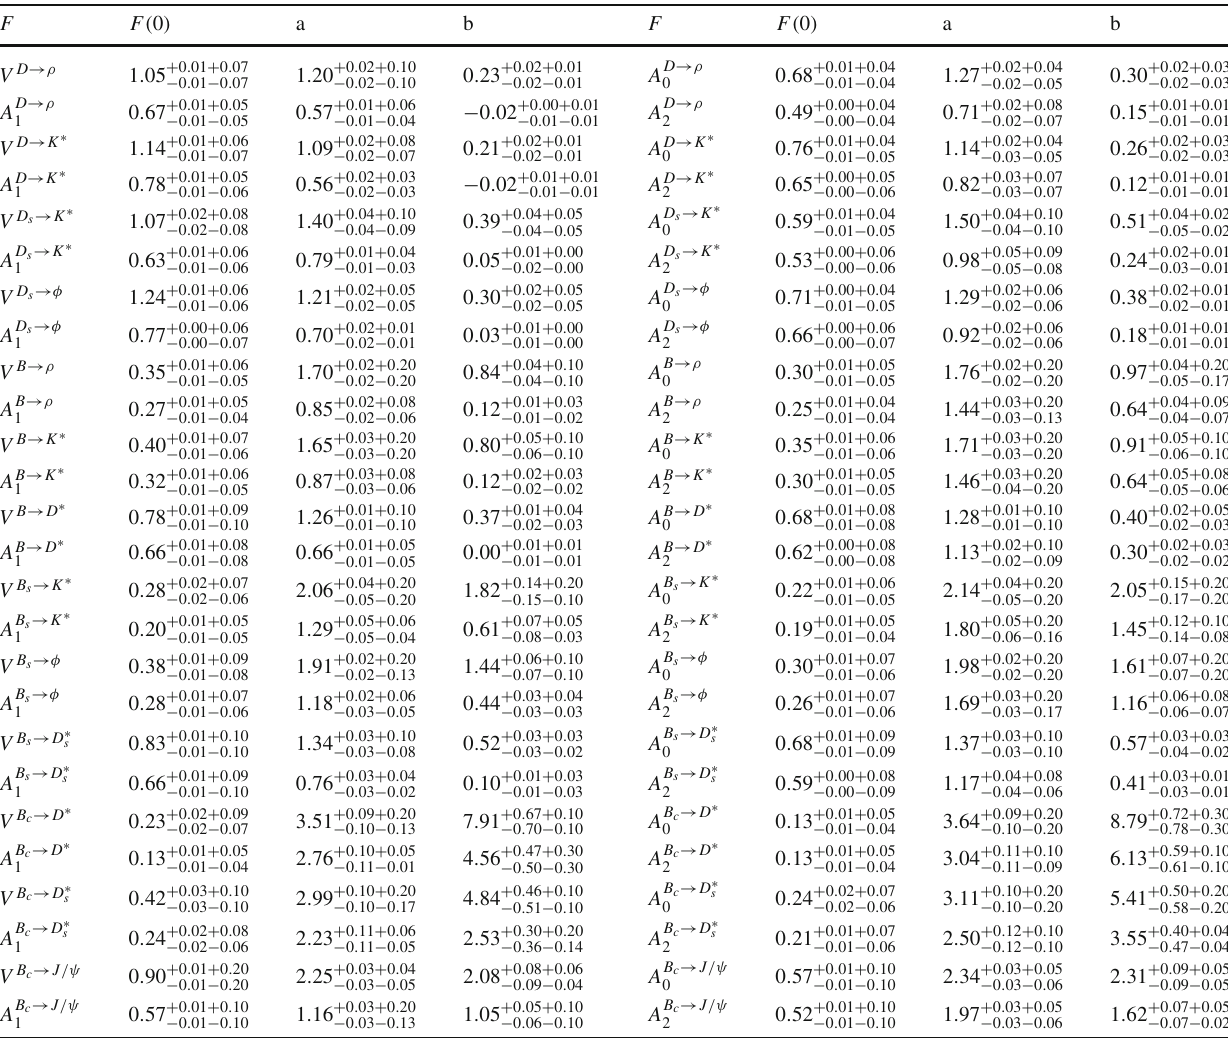
Table 4 The updated results of form factors for some P → V